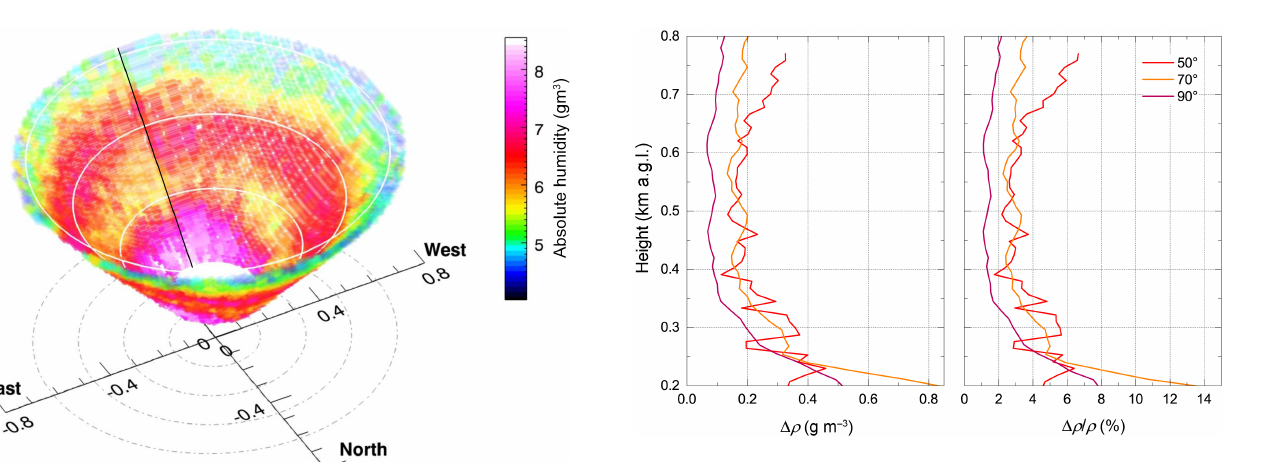
Figure 9. Absolute noise (cid:49)ρ and relative noise (cid:49)ρ/ρ profiles of selected parts of the volume scan with the corresponding temporal and spatial resolution of 10s and 67.5m,